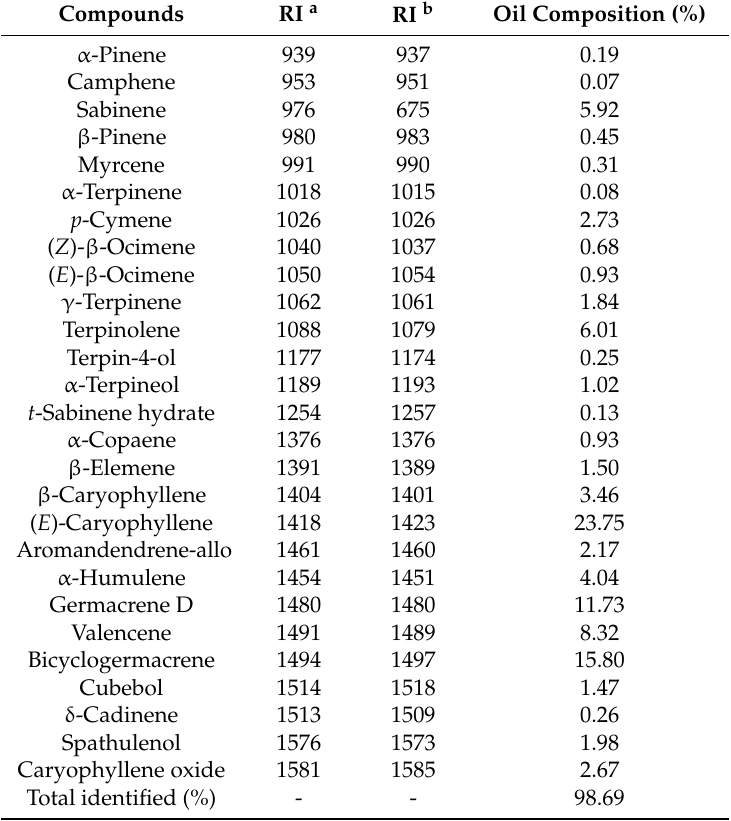
Table 1. Composition of Lantana camara leaf essential oil.